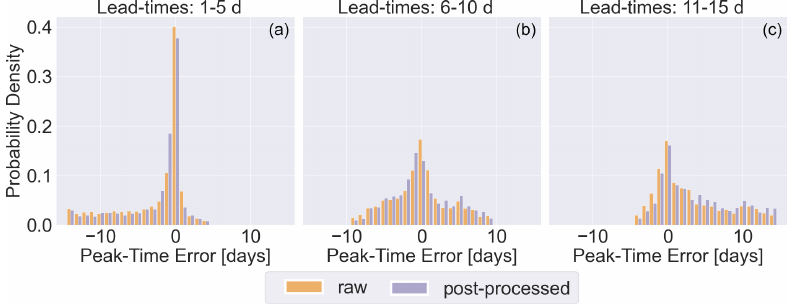
Figure 6. Histograms showing the probability distribution of peak-time errors for all forecasts where the maximum observation is above the 90th percentile for the station (26807 forecasts) for raw forecasts (orange) and post-processed forecasts (purple). (a) Maximum observations occur at lead times of 1 to 5d. (b) Maximum observations occur at lead times of 6 to 10d. (c) Maximum observations occur at lead times of 10 to 15d.